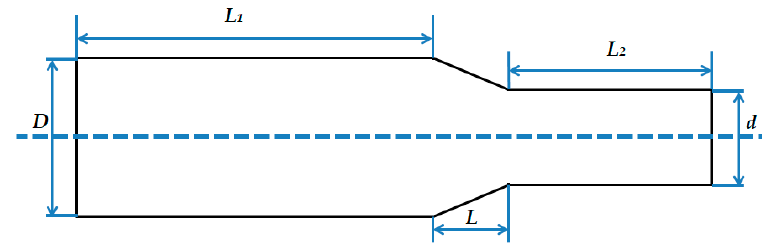
Figure 8. The model diagram of reducer.